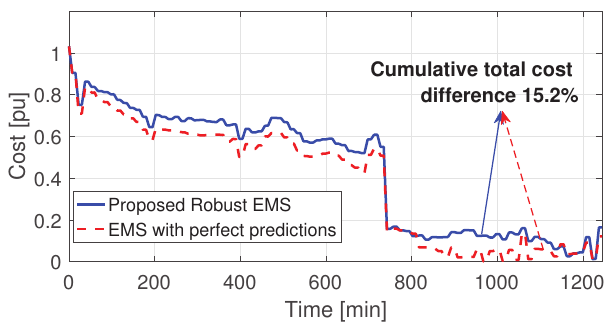
Figure 4. Evolution of the operating costs during the